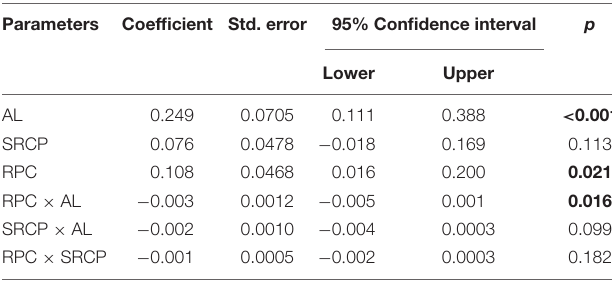
TABLE 6 | Multivariate GEE analysis based on the BCVA as the